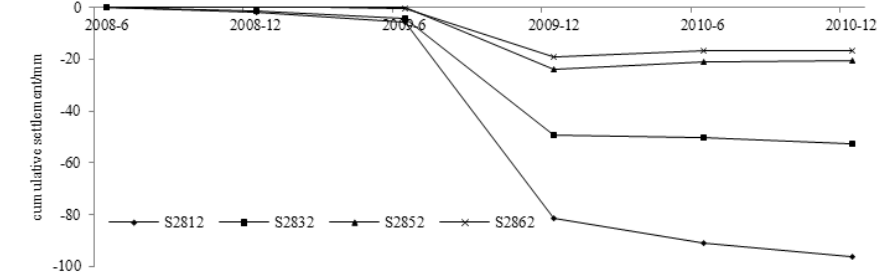
Figure 8. Duration curve of cumulative settlement in typical C sites nearby the